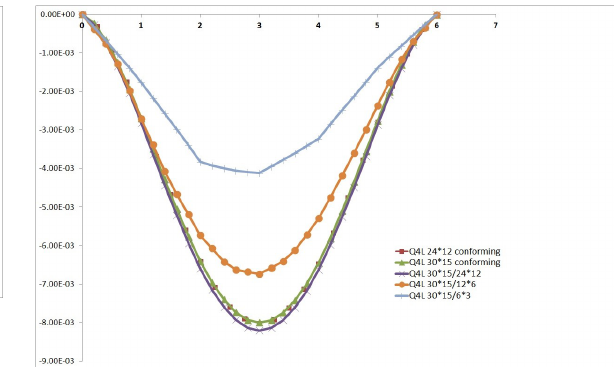
Figure 15: Transverse displacement u 3 distribution for a double- layer shell with Q4 elements and linked interpolation using con- forming and non-conforming mesh configurations.